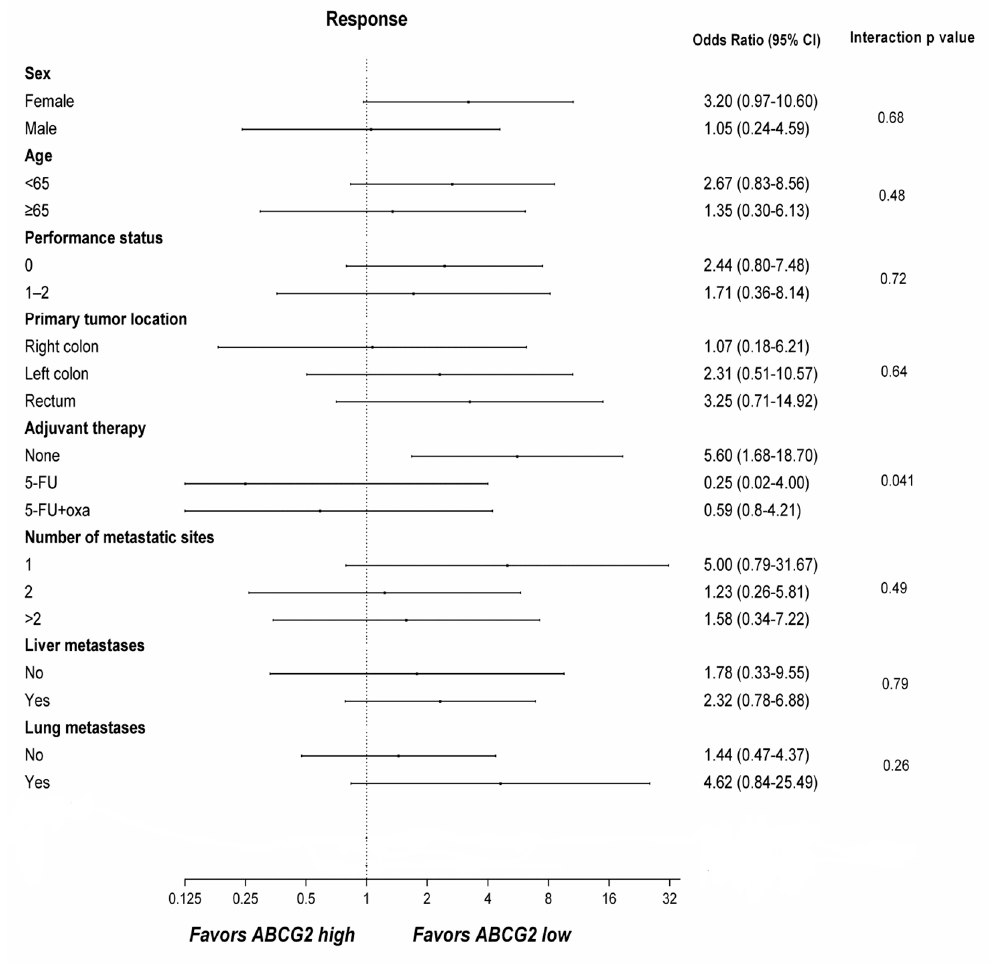
Figure 3. Exploratory predictive factor analyses of response to irinotecan containing treatment ( n =